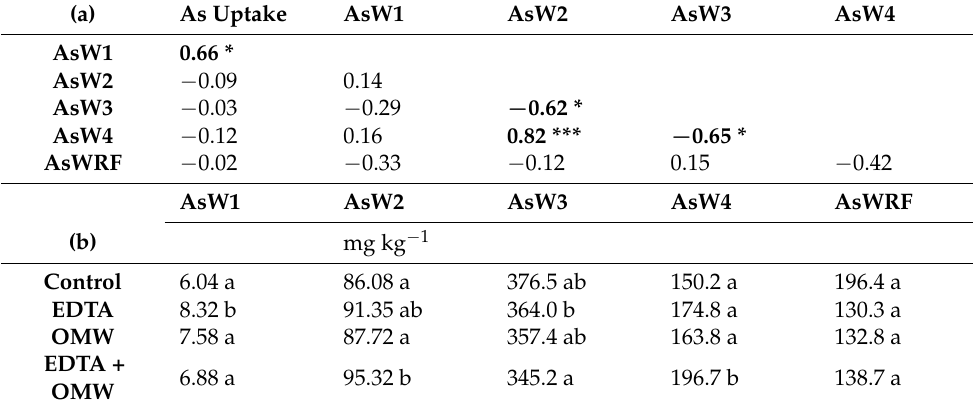
Figure 4. Biplot of the first two principal components regarding As uptake by H. annuus and different soil fractions among different treatments. W1: nonspecifically sorbed; W2: specifically sorbed; W3: amorphous hydrous-oxide-bound; W4: crystalline hydrous-oxide-bound; WRF: residual fraction; OMW: olive mill wastewater. Table 3. ( a ) Pearson correlation matrix between As uptake by H. annuus and the respective soil fractions, as extracted by the Wenzel sequential extraction protocol. ( b ) As distribution between different soil fractions as determined by the Wenzel sequential extraction protocol, among different treatments. Comparisons performed by Tukey’s HSD test ( p ≤ 0.05) are demonstrated with lowercase letters and are valid within each soil fraction. The presence of a common letter implies no significant difference. *, *** indicate significant r values at p < 0.05 and 0.001, respectively ( n =